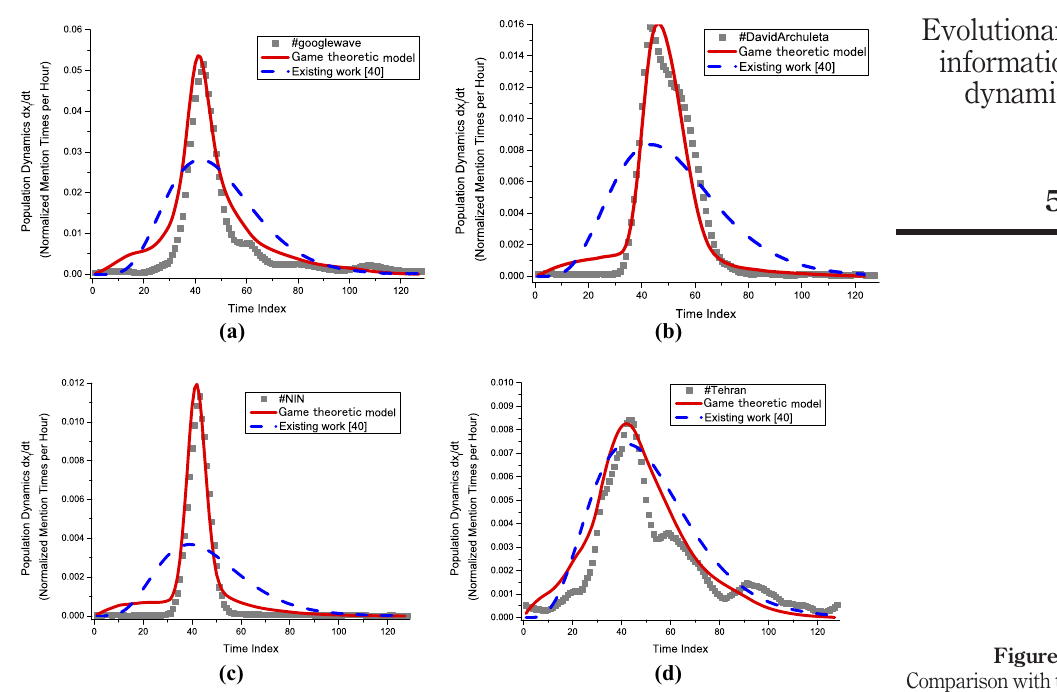
Figure 5. Comparison with